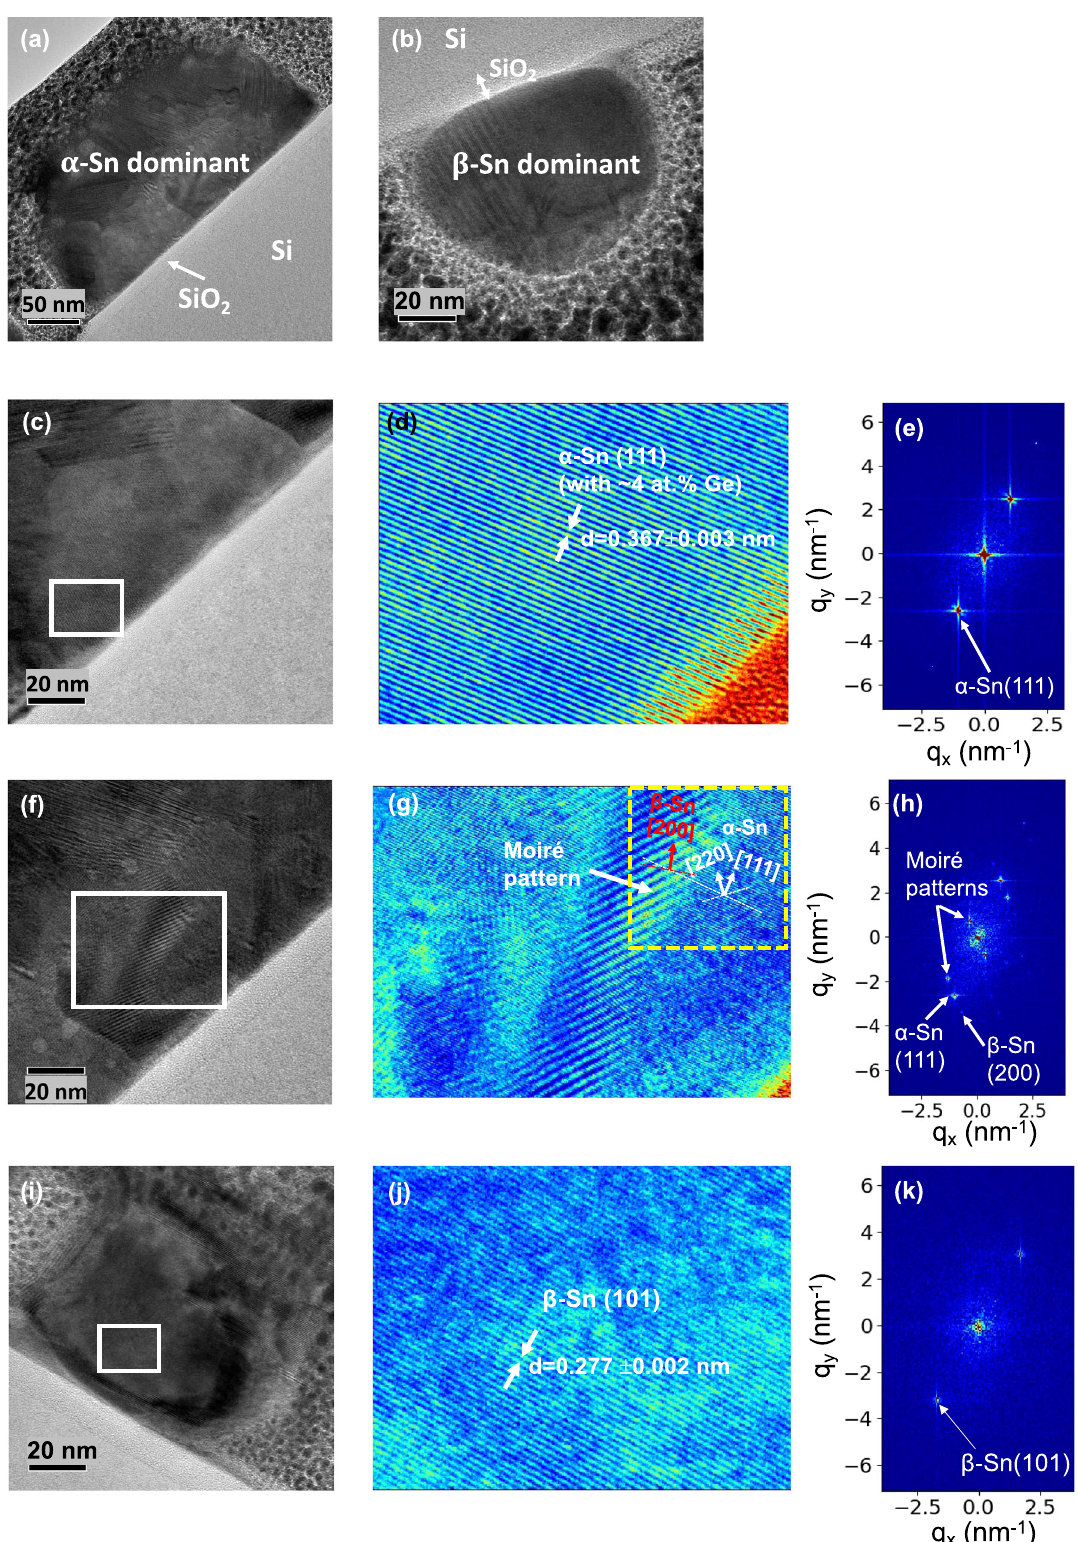
Fig. 6 HRTEM images of SnGe microdots annealed at 350 °C. a A SnGe microdot with a “ trapezoid ” morphology dominated by α -Sn. b A SnGe microdot with a “ dome ” morphology dominated by β -Sn. c A zoomed-in HRTEM image of a pure α -Sn region in the SnGe microdot shown in Figure a . To show the crystal planes more clearly, the boxed region in c is highlighted in d by converting the brightness contrast into color contrast, i.e., red for brighter and blue for darker regions. Panel e shows a Fourier transform of d in order to obtain the d spacing and the corresponding Miller indices, as labeled in d and e . Panels f – h zoomed into an α / β overlapped region of Figure a , showing Moiré fringes due to vertical overlapping of α -Sn planes with β -Sn(200) planes. Panels i – k correspond to a pure β -Sn